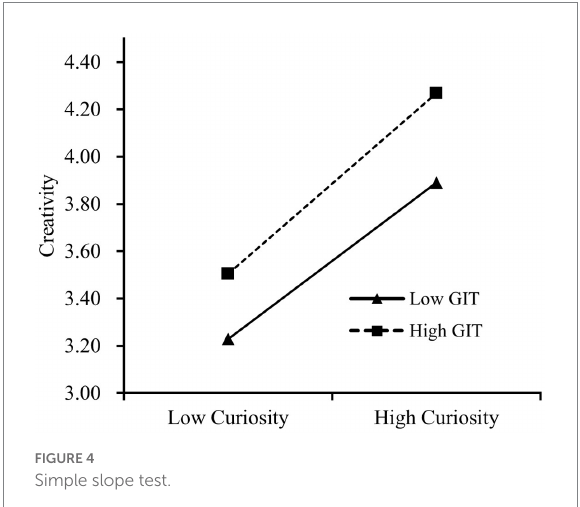
FIGURE 4 Simple slope